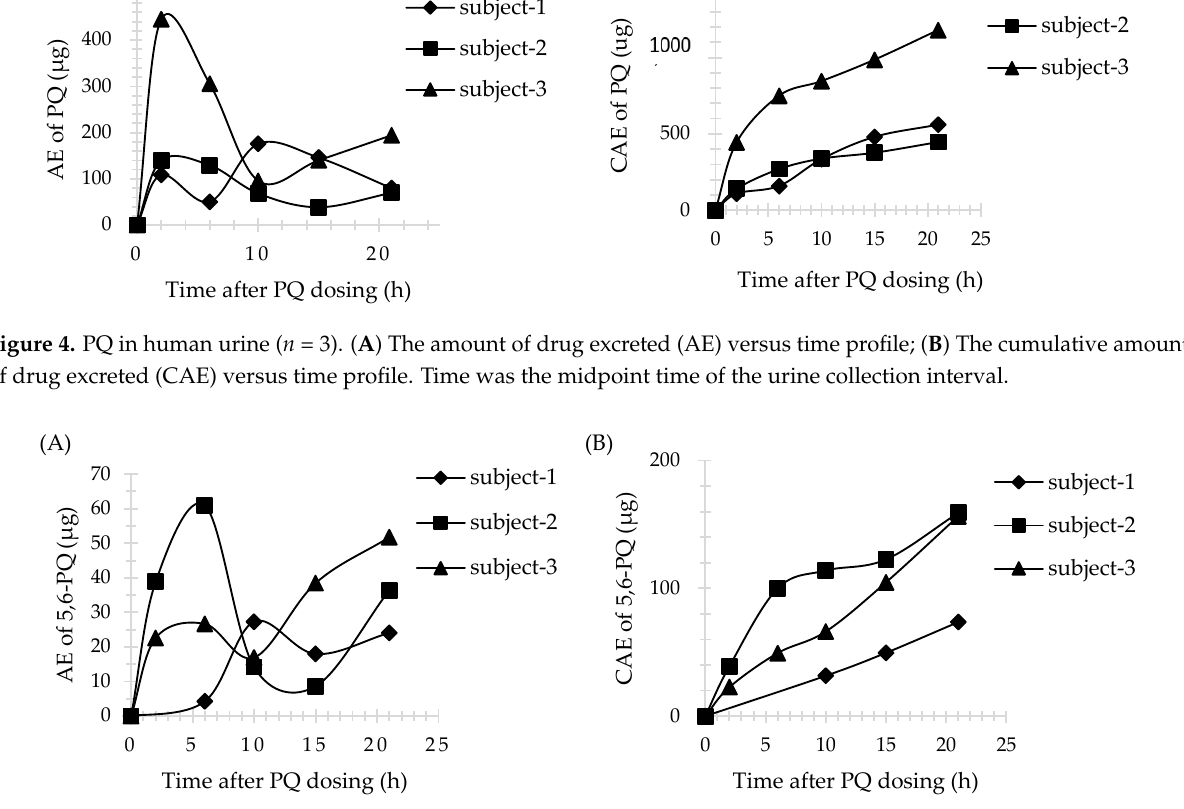
Figure 5. 5,6-PQ in human urine ( n = 3). ( A ) AE versus time profile. ( B ) CAE versus time profile. Time was the midpoint time of the urine collection interval. Table 3. Pharmacokinetic parameters of PQ in human plasma ( n = 3).